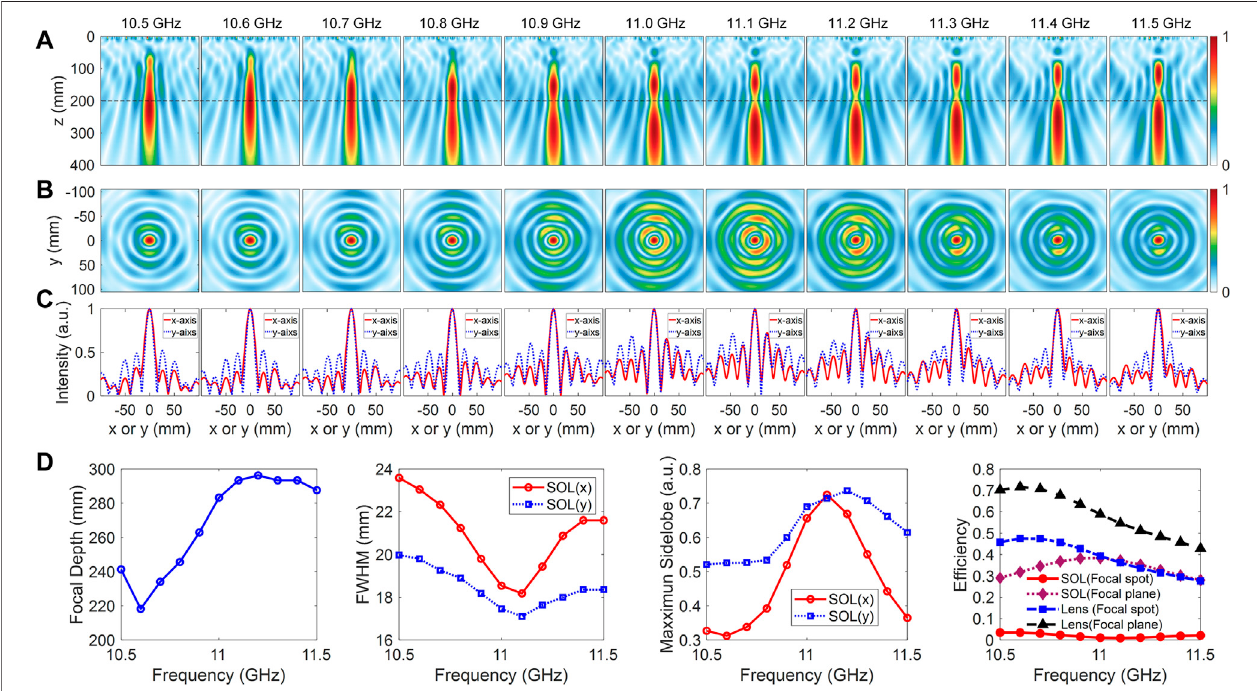
FIGURE 8 | Simulated normalized E x fi eld distribution from 10.5 to 11.5 GHz on (A) the XZ plane at y (cid:1) 0 mm (dash line is z (cid:1) 200 mm), (B) the focal plane at z (cid:1) 200 mm, and (C) along the x and y axes on the focal plane. (D) The focal depth, FWHM, normalized maximum sidelobe along the x and y axes, and focusing and transmission ef fi ciency of SOL and the lens on the focal plane in 10.5 – 11.5